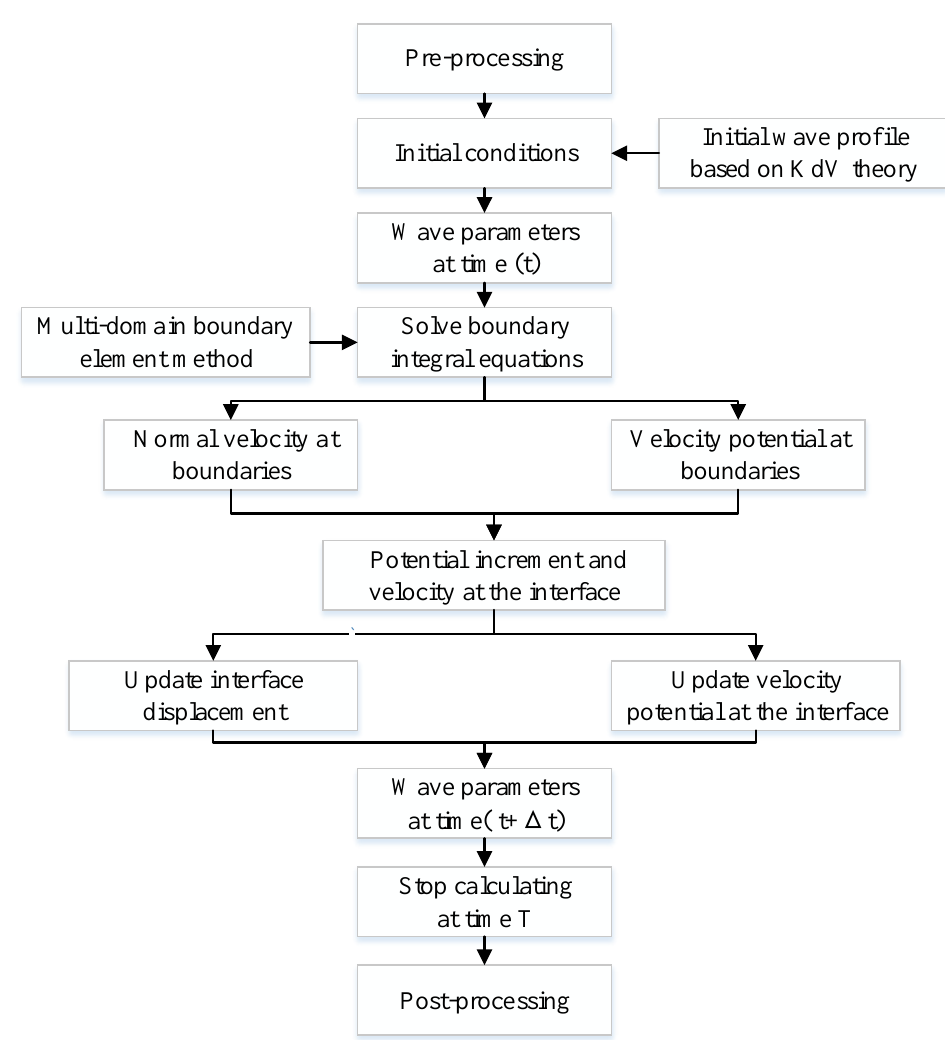
Figure 3. The flowchart which numerical simulations followed in the current study.